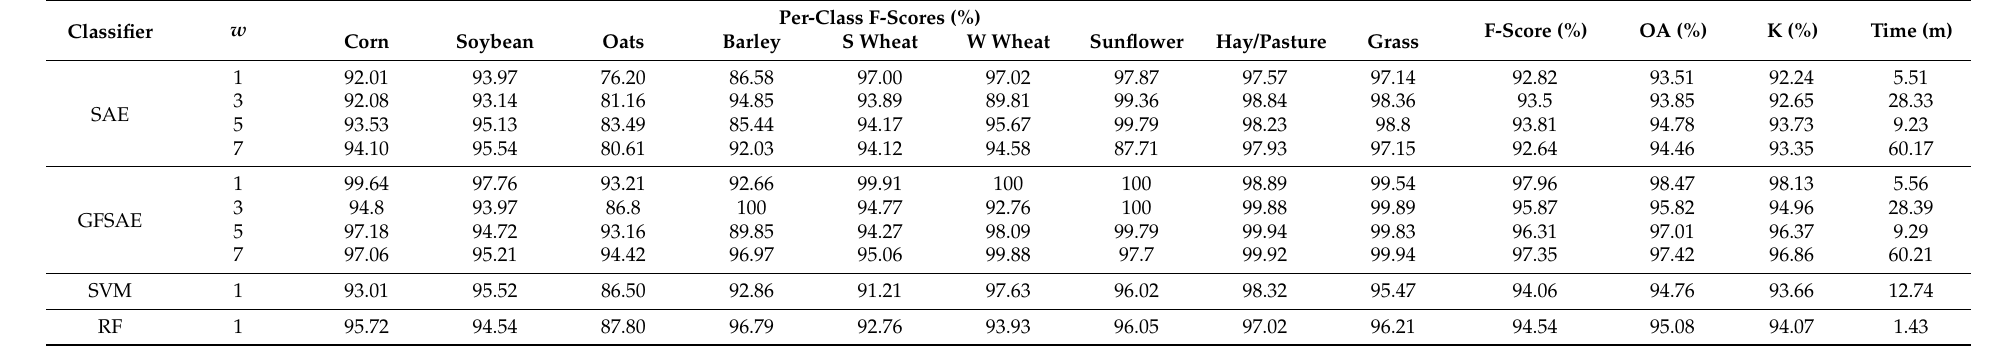
Table 4. Accuracy metrics and training time obtained on the CEF